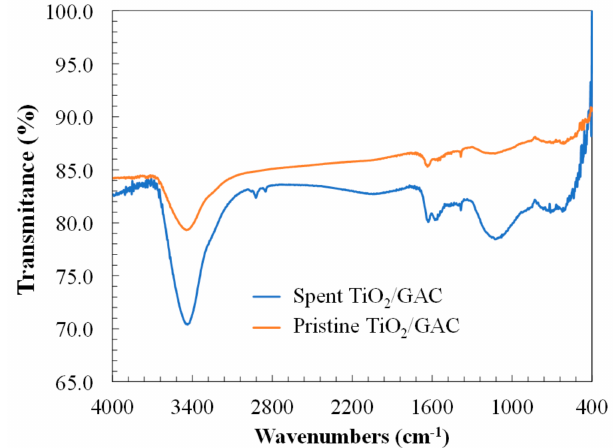
Figure 4. FTIR spectra of pristine and spent TiO 2 / GAC composite in the aniline catalytic ozonation. Experimental conditions: Q G = 4 L min − 1 ; C O P = 1 atm; V reac = 1.5 L; ( Agitation ) = 60